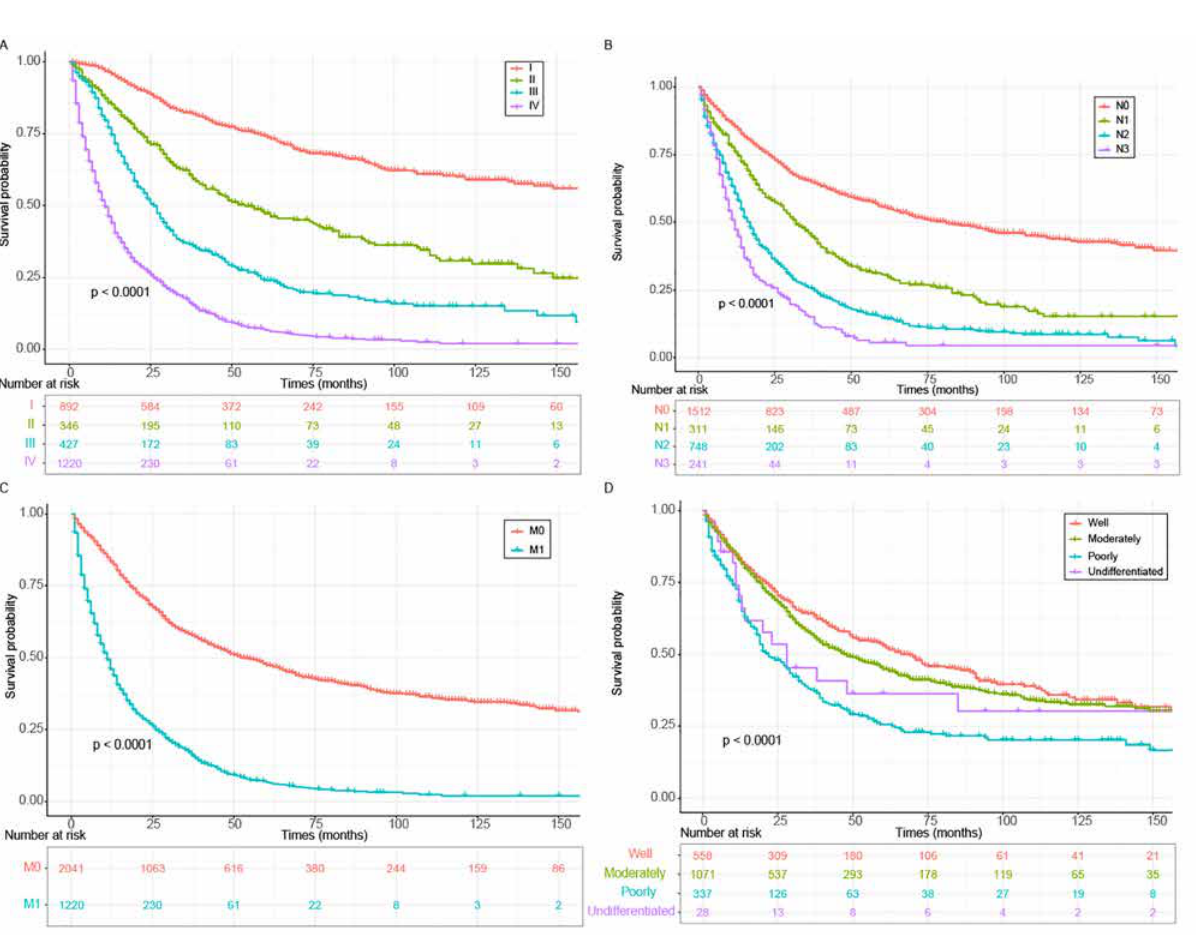
Figure 2: OS for primary pulmonary PA patients classified by (A) TNM stages. (B) lymph node involvement. (C) distant metastases. (D) patho- logical differentiation